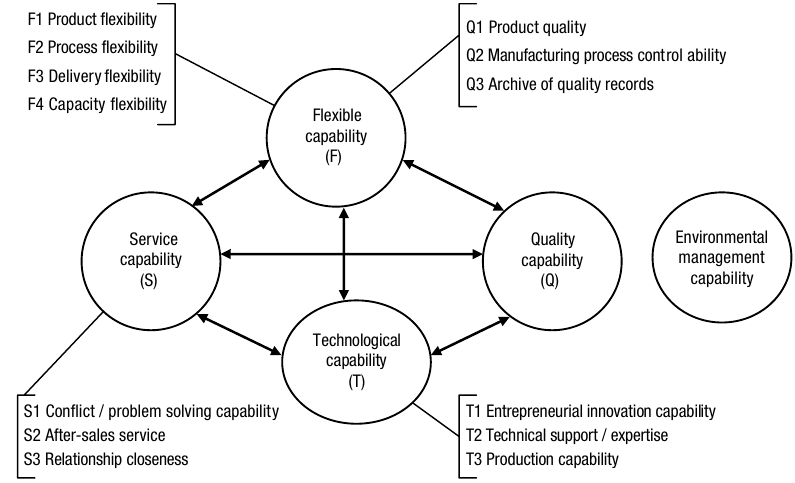
Fig. 1. ANP networked evaluation structure for supplier